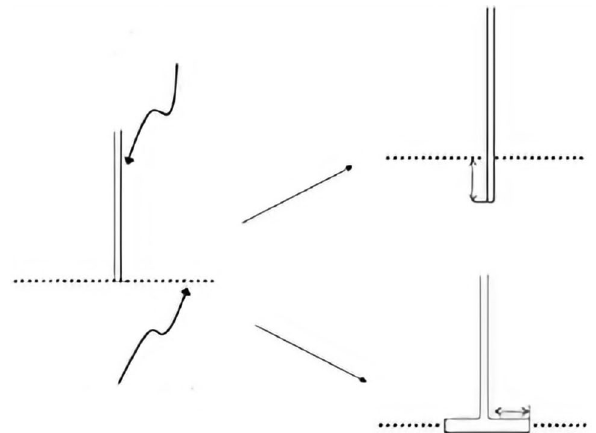
Fig. 1 Various scenarios after collision between natural fracture and hydraulic